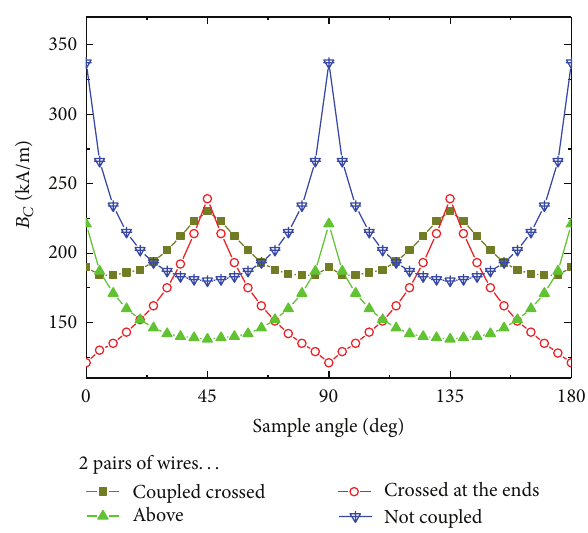
Figure 2: Simulated coercivities of the magnetic systems depicted in Figure